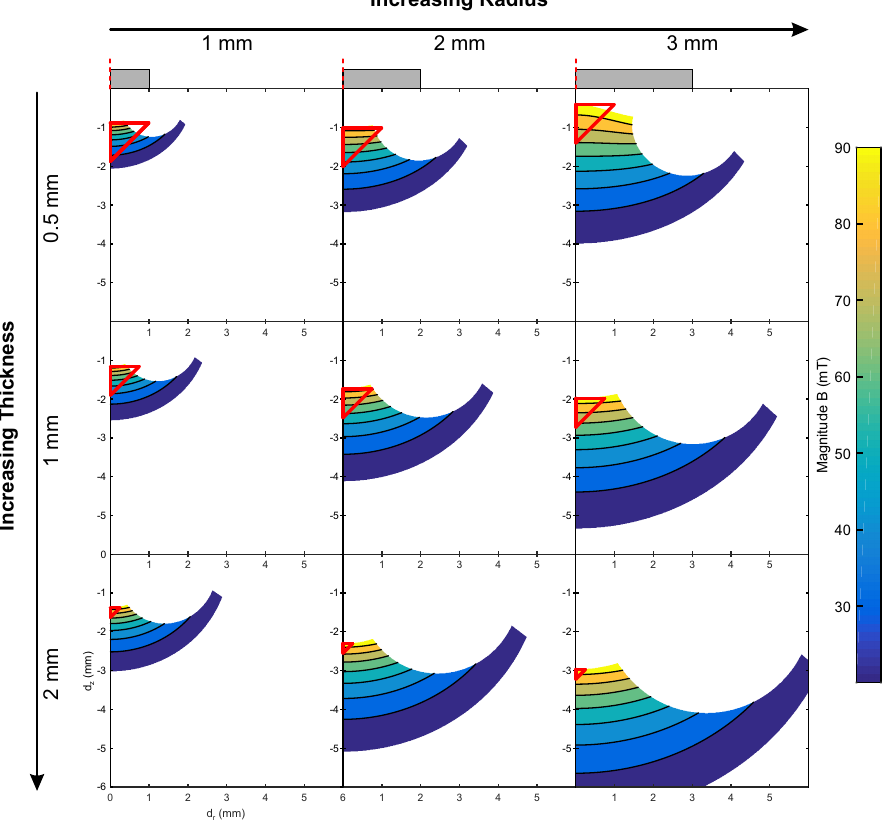
Figure 4. The changing size and position of the “measurable area” in the magnetic field with both magnet thickness and radius. Working areas for the magnets are indicated as red triangles. The working area is located at the point closest to the magnet, where the entire working area is contained within the measurable area, ensuring maximum sensitivity. d z and d r represent the vertical and horizontal movement of the magnet,